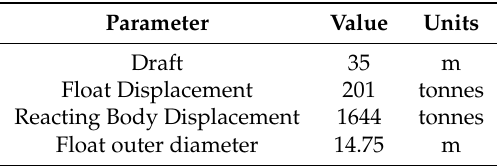
Figure 1. Schematic of the two-body WEC configuration Table 3. Summary specifications of the two-body WEC.